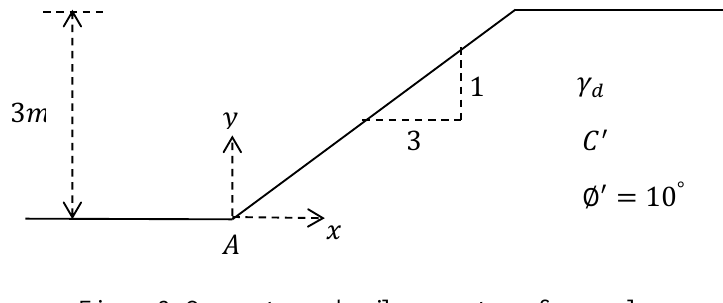
Figure 3. Geometry and soil parameters of example Table 3. Upper and lower bounds of unknown